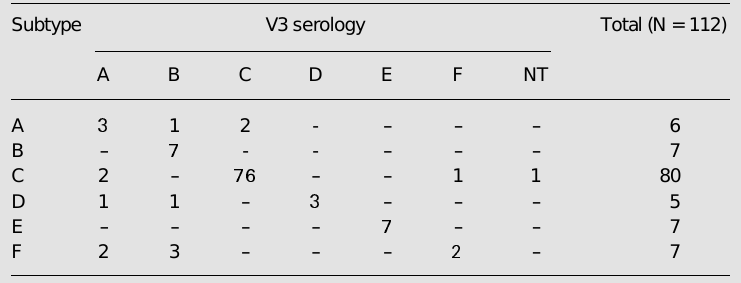
Table 2. EIA V3 serotyping using samples from subtypes A-F of HIV-1 compared to results obtained by HMA and DNA sequencing.